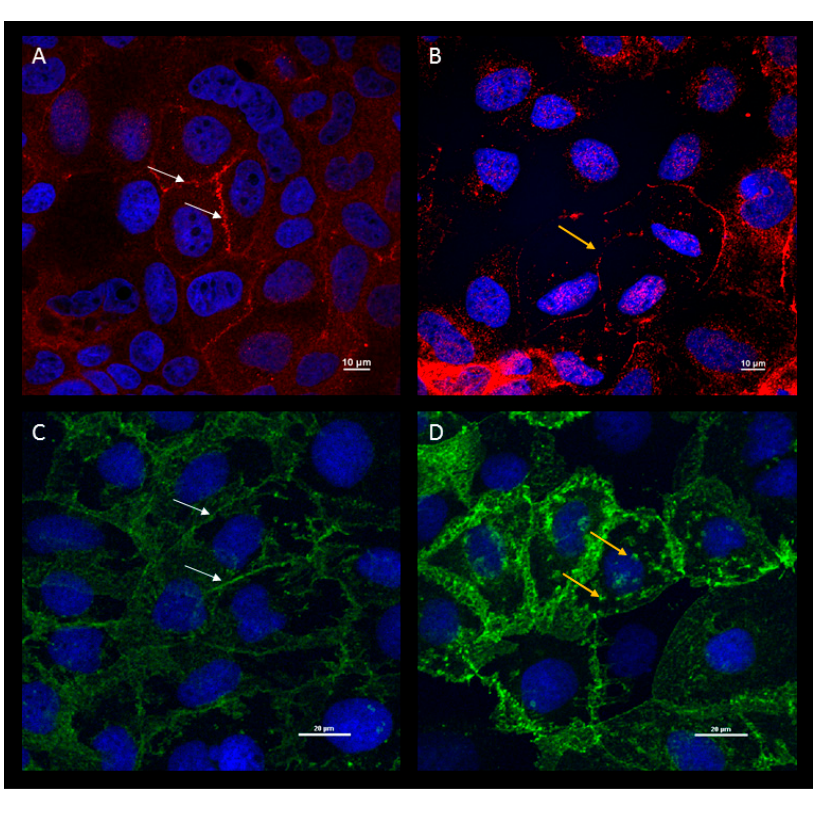
Figure 2. HAstV ‐ 1 infection causes a loss of occludin and relocalization of e ‐ cadherin. Mock ( A , C ) or HAstV ‐ 1 ‐ infected ( B , D ) human colon carcinoma cells type 2 (Caco ‐ 2) were stained for occludin (red, A , B ), e ‐ cadherin (green, C , D ) or DAPI (blue) 24 h post ‐ infection (hpi) and imaged by confocal microscopy. White arrows show normal junction appearance, while yellow arrows indicate apparent relocalization junction proteins. Magnification bars shown inset.